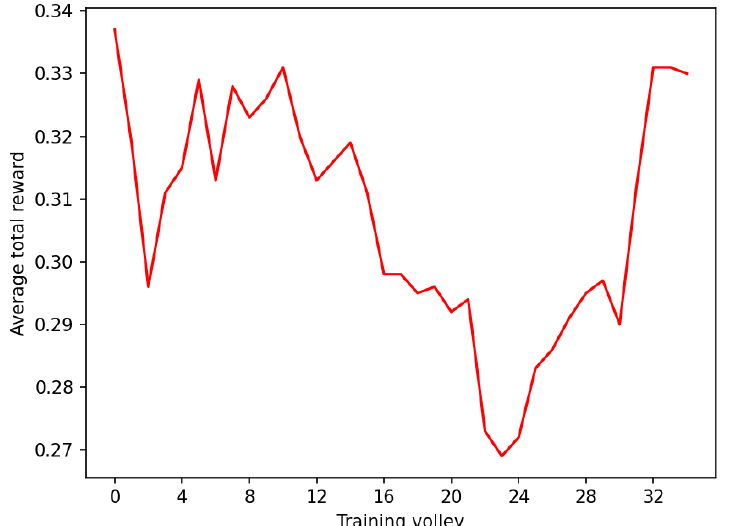
Figure 5. Average total rewards during training of π RF with N = 2 and T = 100. Volleys are composed of 2000 episodes